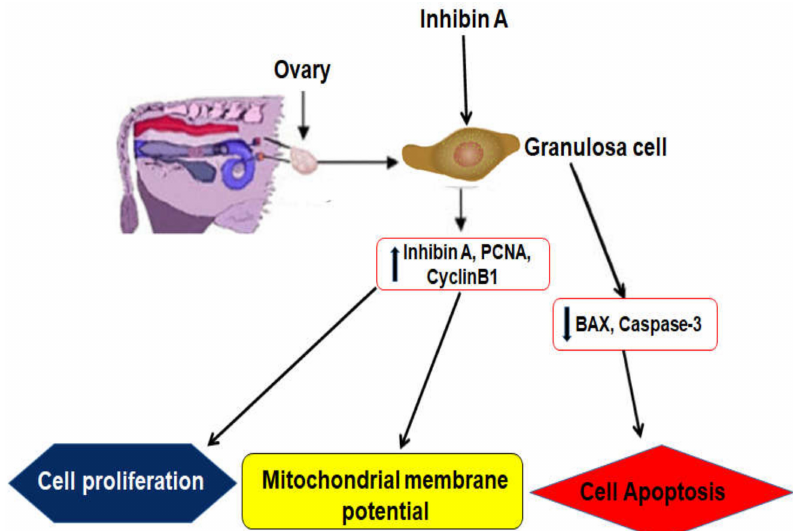
Figure 7. Mechanisms of regulating inhibin A response related to GC function within a bovine ovary. The upregulated genes inhibin A, PCNA, and CyclineB1 were involved in the regulating mechanism of GCs via boosting cell proliferation and mitochondrial membrane potential. Under inhibin A treatment, the downregulated genes BAX and Caspase-3 were involved in inhibiting GC apoptosis, which might enhance the possibility of GCs viability and follicle